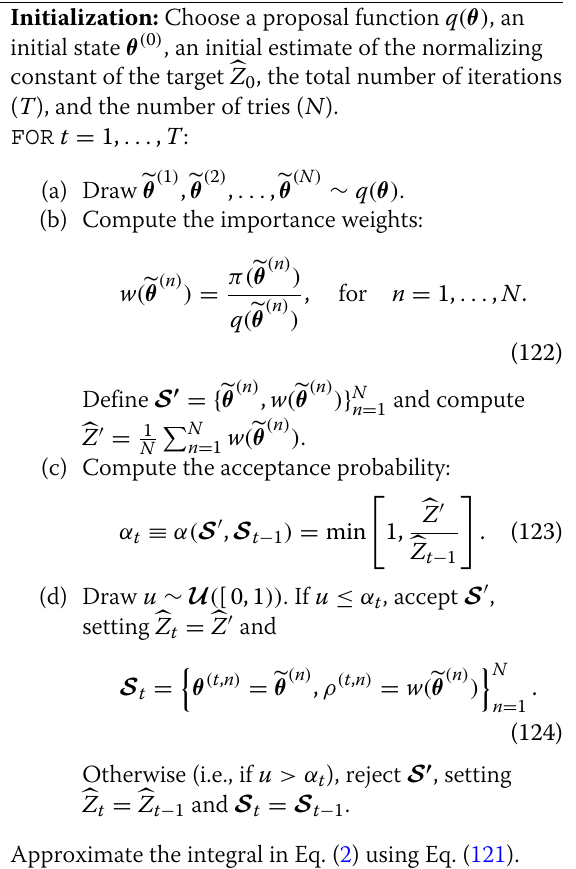
Algorithm 24 Group Metropolis Sampling